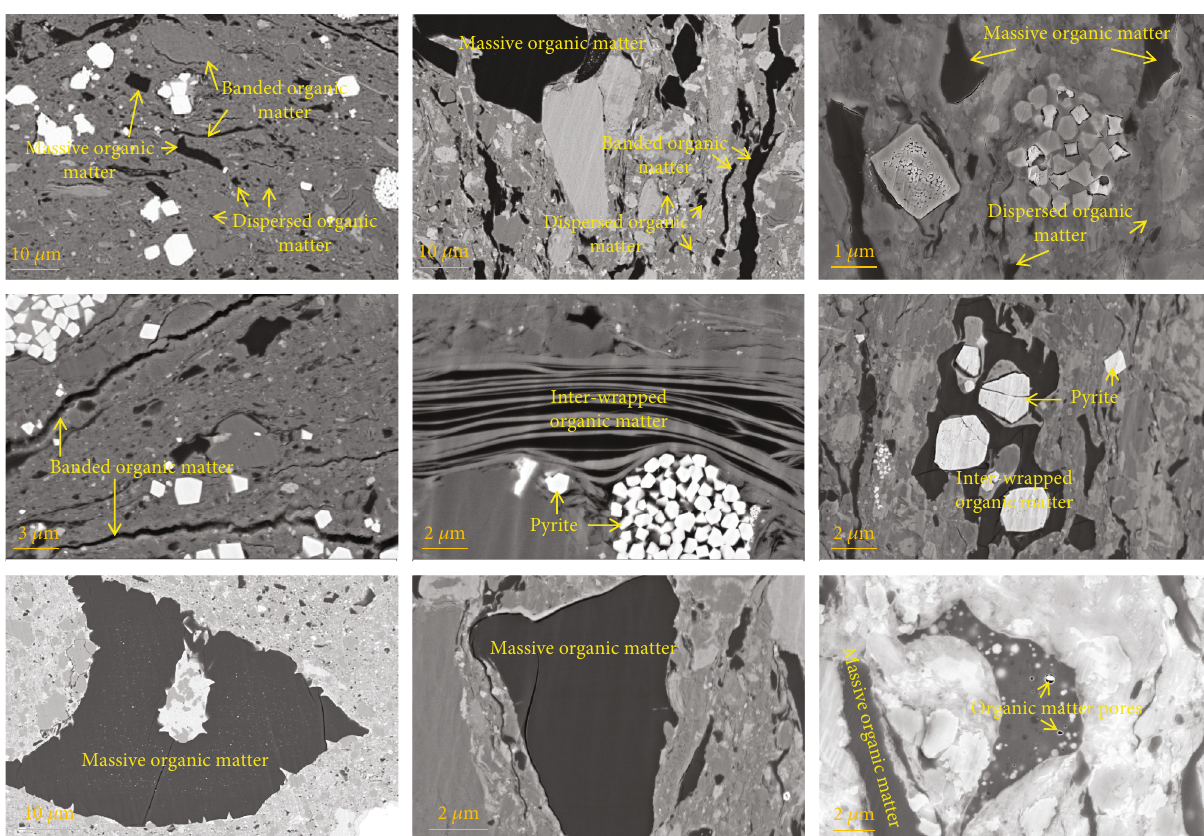
Figure 4: Occurrences of organic matter in the Longtan coal series